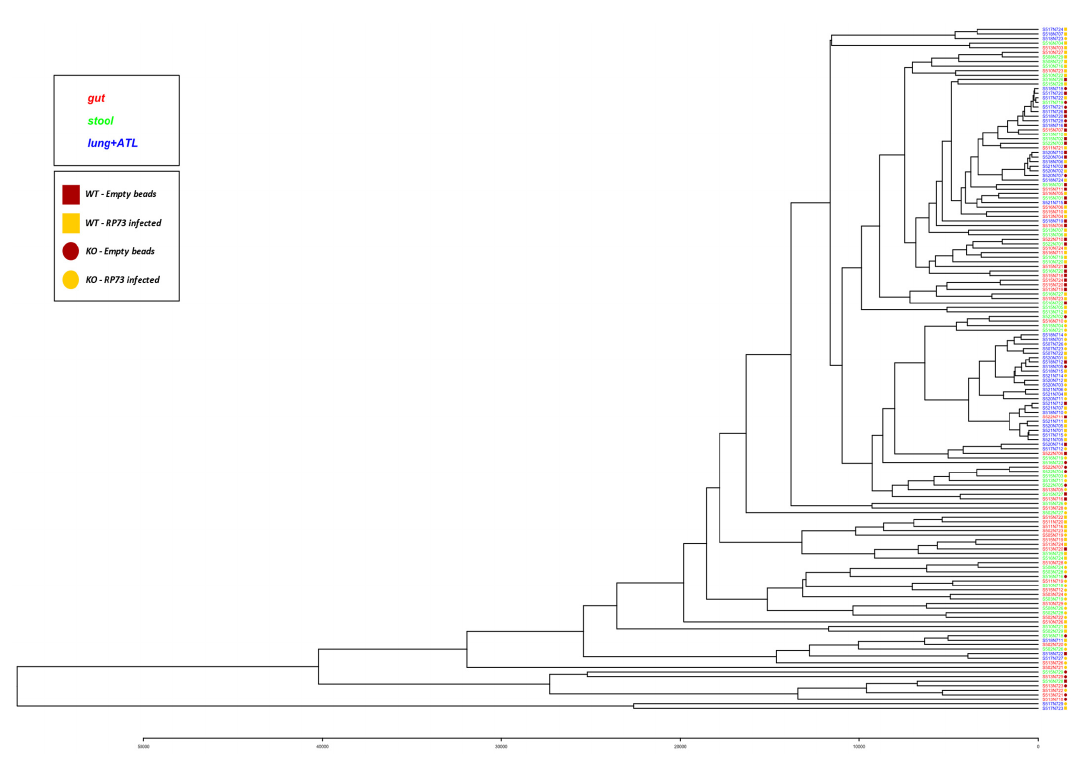
Figure 2. Clustering of mice microbiota. Codes of samples are as those reported in Table